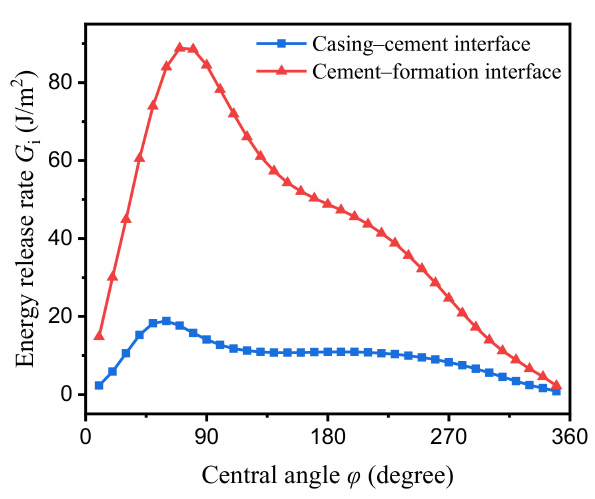
Figure 3. The energy release rate at the interfaces as a function of the central angle of the crack.